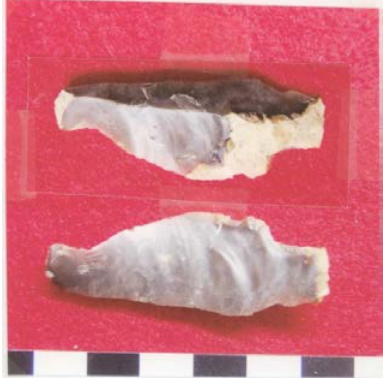
Figure 8. Ventral and dorsal views of a prismatic blade excavated from the Hensler Petroglyph site. The material is Knife River Flint. The blade edge has been completely used. The scale is in centimeters. Photo by